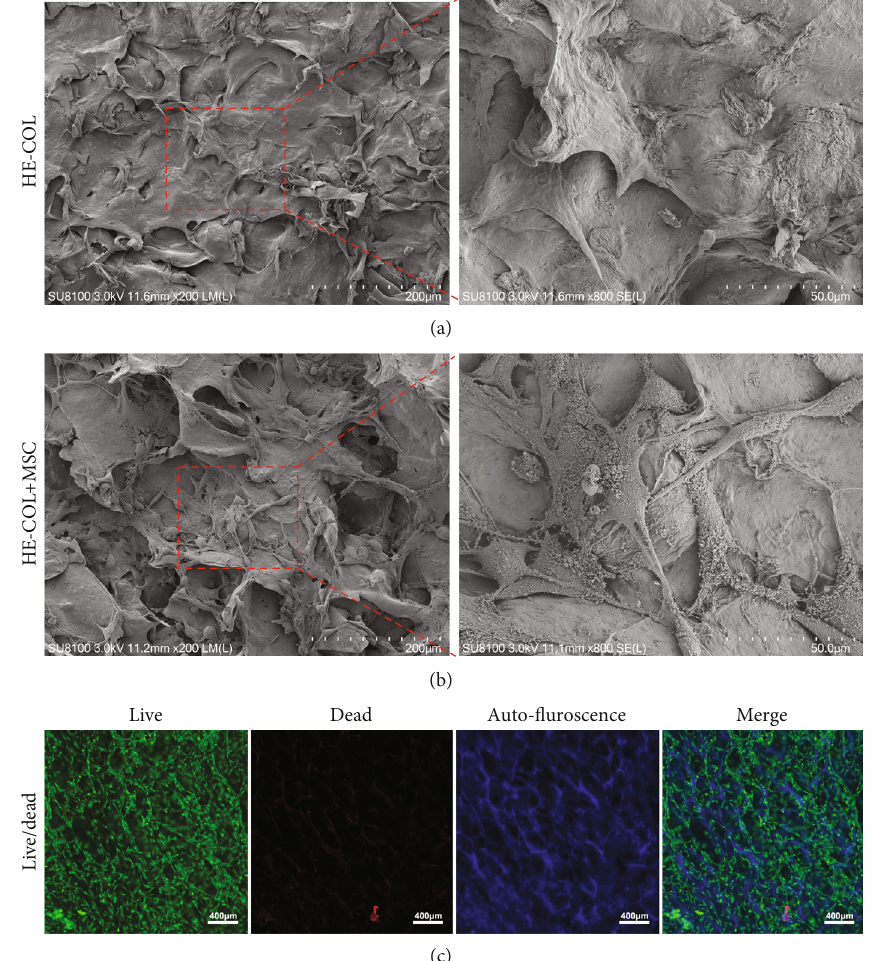
Figure 1: (a) SEM images of nHA/COL sca ff olds; (b) SEM images of tissue-engineered laminae (TEL); (c) Live/Dead staining of TEL.